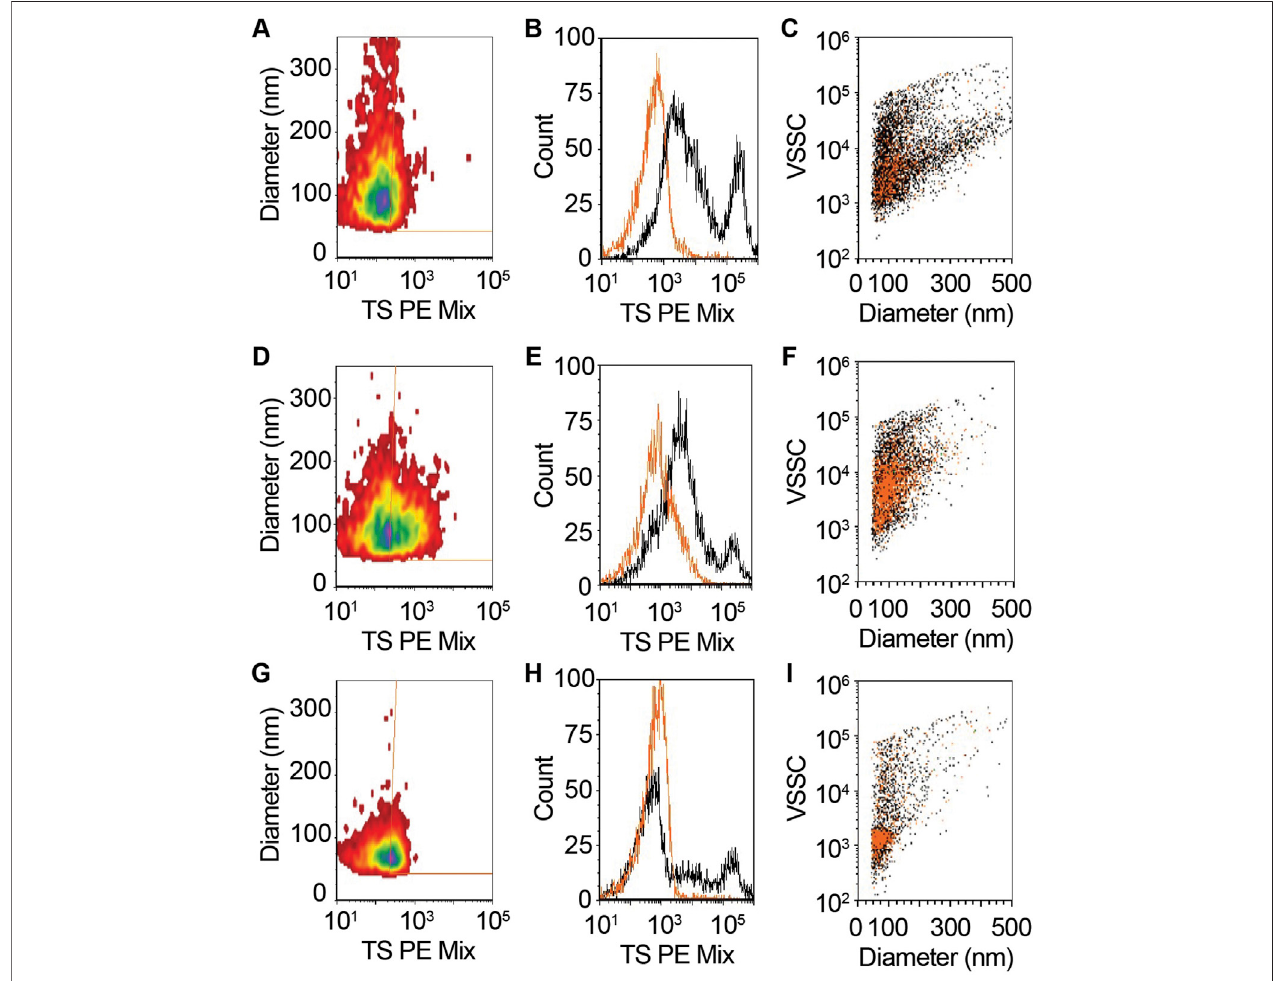
FIGURE 2 | CSF contains tetraspanin (CD9, CD63, and CD81)-positive EVs. (A – C) Unconcentrated and (D – F) 25x concentrated CSF was stained with vFRed, plus a pool of PE conjugated antibodies to CD9, CD63, and CD81 (TS PE mix). (G – I) Treatment of stained 25x CSF with 0.1% triton X100 demonstrated the vesicular nature of the measured positive events in panels (D – F) . (A,D,G) Diameter vs. fl uorescence distributions of TS + EVs. (B,E,H) One parameter histogram overlays of CSF with (orange) and without (black) TS + staining. (C,F,I) Staining events backgated onto diameter vs. violet side scatter (VSSC) for TS PE. vFRed + events are black and TS + events are